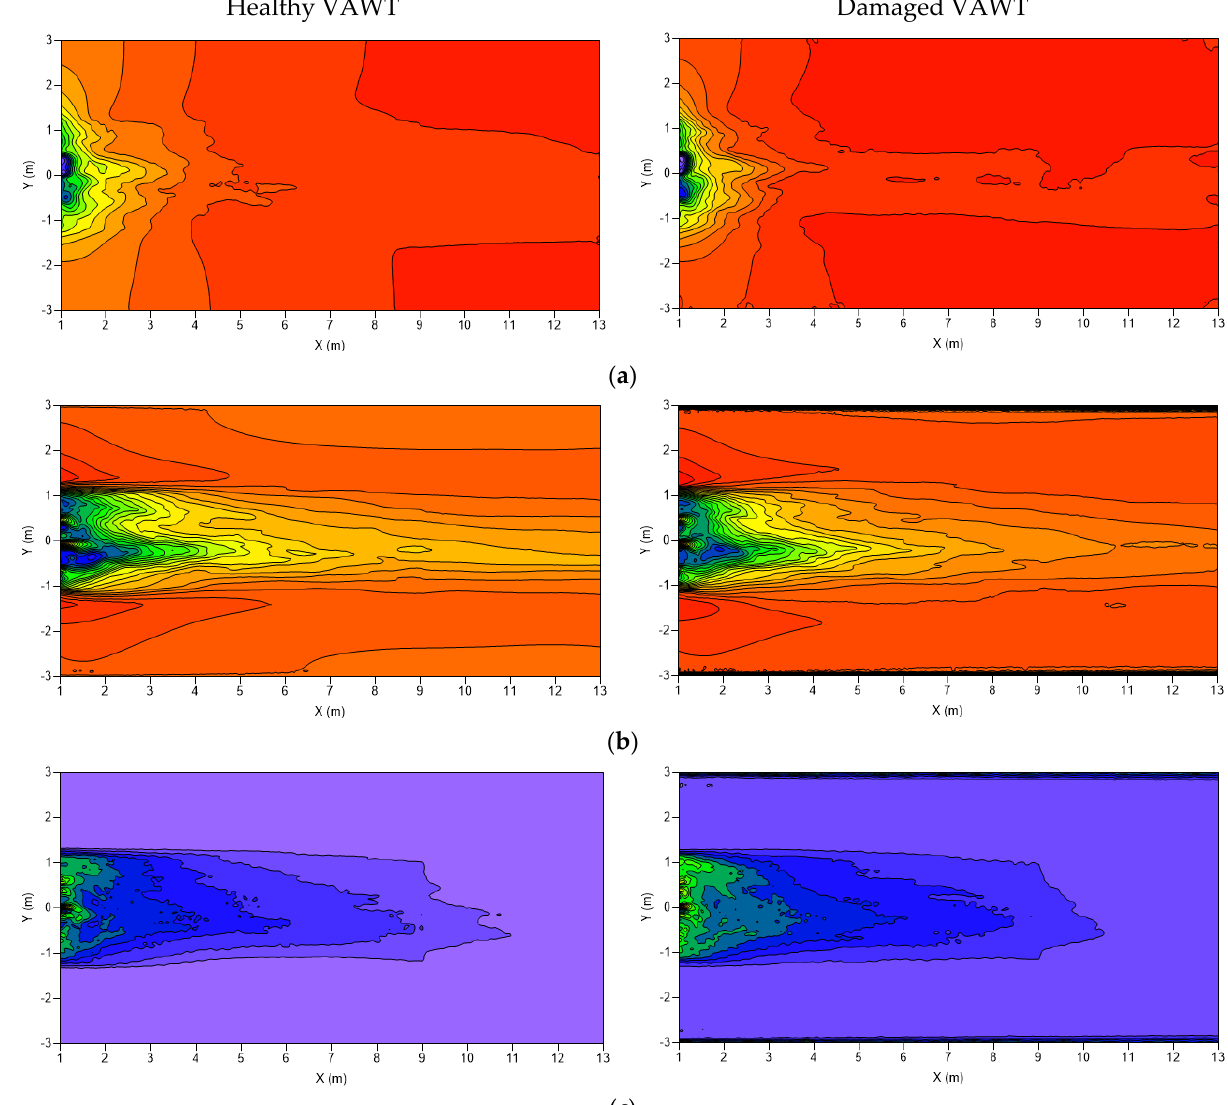
Figure 13. φ 1 distribution in the wake region of healthy and damaged VAWTs: ( a ) Pressure-based, ( b ) Velocity-based ( c ) Vorticity-based.